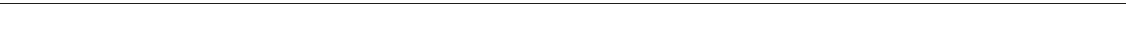
Fig. 5 JNK inhibits Bim expression through suppressing Smurf2-mediated degradation of Ezh2. a mRNA (left) and protein (right) levels of Ezh2 in human erythroblasts triggered by SP600125 assessed by q-PCR or immunoblotting. b Ezh2 protein level induced by JNK1 silencing measured by immunoblotting. c Time course of Ezh2 levels in CHX-treated human erythroblasts with DMSO or SP600125. d SP600125-induced degradation of Ezh2 in the presence of DMSO or MG132 (10 µ M) by immunoblotting. e mRNA expression of HOXA9 in human erythroblasts induced by SP600125 (left) or JNK1 shRNA (right) by q-PCR. f Quantitative chromatin immunoprecipitation analysis of occupancy of Ezh2 (left, n = 5) and H3K27me3 (right, n = 3) on Bim promoter in human erythroblasts treated with vehicle or SP600125. g mRNA (left) and protein (right) levels of Bim induced by GSK126 (5 µ M) for 12 h. h Apoptosis of human erythroblasts trigged by GSK126 and measured by fl ow cytometry. i mRNA expression of Bim induced by Ezh2 silencing. j Representative fl ow cytometry pro fi le (left) and quanti fi cation (right) of apoptotic human erythroblasts induced by Ezh2-speci fi c shRNA ( n = 4). k Ezh2 protein levels in P38 α + / − and P38 α − / − erythroblasts by immunoblotting. l mRNA levels of HOXA9 in P38 α + / − and P38 α − / − erythroblasts by q-PCR. m Apoptosis in P38 α + / − and P38 α − / − erythroblasts subjected to GSK126 (5 µ M) ( n = 4). n Protein levels of Ezh2, Smurf2, and Bim in human erythroblasts transduced with control or smurf2-speci fi c shRNA then treated with SP600125. o Representative fl ow cytometry pro fi le (left) and quanti fi cation (right) of SP600125-induced apoptosis of human erythroblasts transduced with control or smurf2-speci fi c shRNA ( n = 3). Blots are representative of two independent experiments. Data are shown as mean ± s.e.m. * P < 0.05 (two-tailed unpaired Student ’ s t